Question: Judging by this figure, is the value going up or going down?
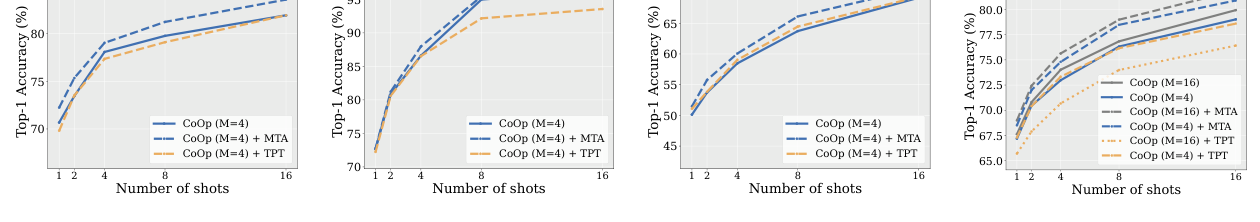
Answer: increasing